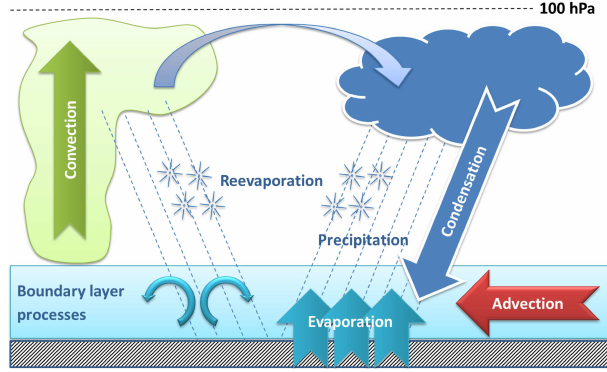
Fig. 11. Schematic representation of the hydrological cycle which includes physical process: advec- Figure 11. Schematic representation of the hydrological cy- tion,deepconvection,large-scalecondensation,re-evaporation,surfaceevaporationandboundary-layer cle which includes physical process: advection, deep convection, processes. large-scale condensation, re-evaporation, surface evaporation and boundary-layer